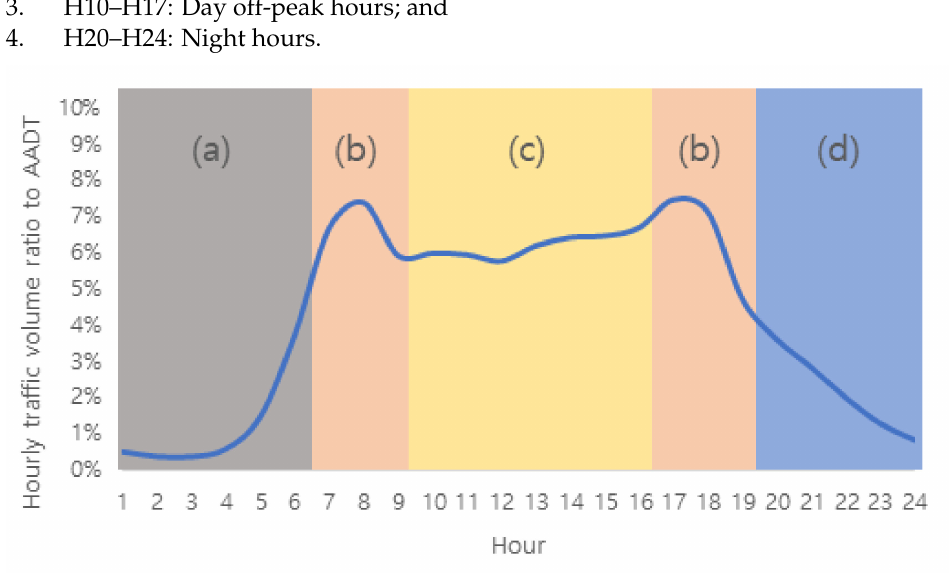
Figure 6. Hour groups extracted from the factor analysis: ( a ) Early morning hours; ( b ) peak hours in the morning and afternoon; ( c ) day off-peak hours; ( d ) night hours.